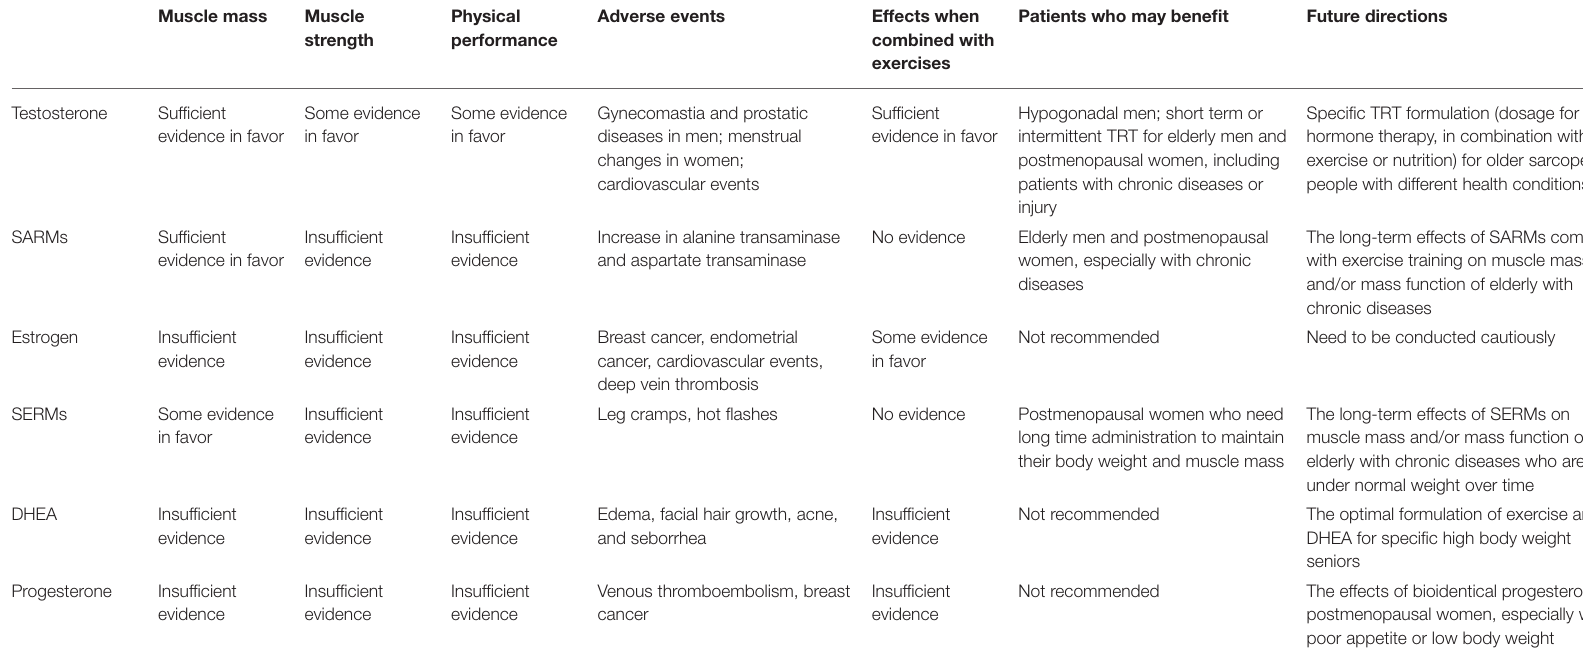
TABLE 2 | Summary of the main effects of sex steroid